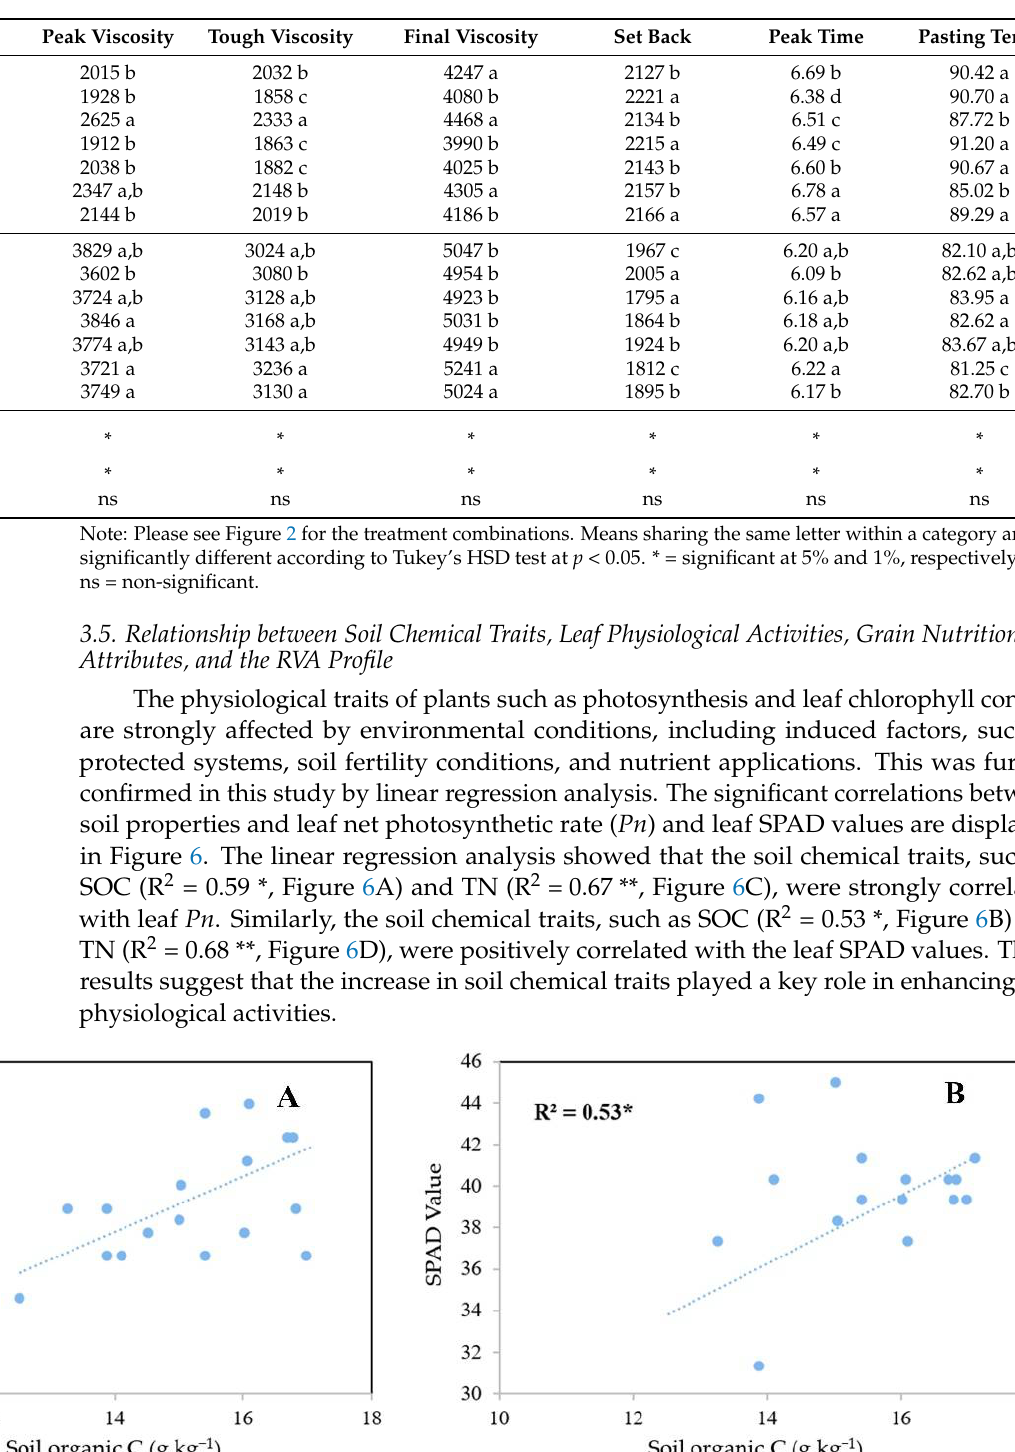
Figure 6. Linear regression analysis of soil organic C ( A , B ) and total N ( C , D ) with soil net photo- synthetic rate and the SPAD values. **, *= significant at 5% and 1%, respectively. n = 18. In addition, we also performed a correlation analysis among the leaf physiological traits and rice grain nutritional attributes (Figure 7). The linear regression analysis re- vealed that grain nutritional traits, such as SC (R 2 = 0.50 *, Figure 7A) and AC (R 2 = 0.58 *, Figure 7B), were positively correlated with leaf Pn. Similarly, the grain nutritional traits, such as SC (R 2 = 0.60 *, Figure 7C) and AC (R 2 = 0.61 *, Figure 7D), were positively corre- lated with the leaf SPAD values. Moreover, the heatmap correlation analysis revealed a positive correlation among the soil properties (SOC, TN, and AN), leaf physiological traits ( Pn and SPAD values), grain nutritional attributes (SC, AC, and PC), and starch RVA pro- file features (PV, TV, FV, SB, and PT) (Figure 8). The linear regression analysis results confirmed that the increases in soil nutrient content, particularly in SOC and TN, de- scribed the highest proportion of the difference in the leaf physiological activities. Hence, changes in leaf physiological activities are closely associated with rice grain nutritional traits.